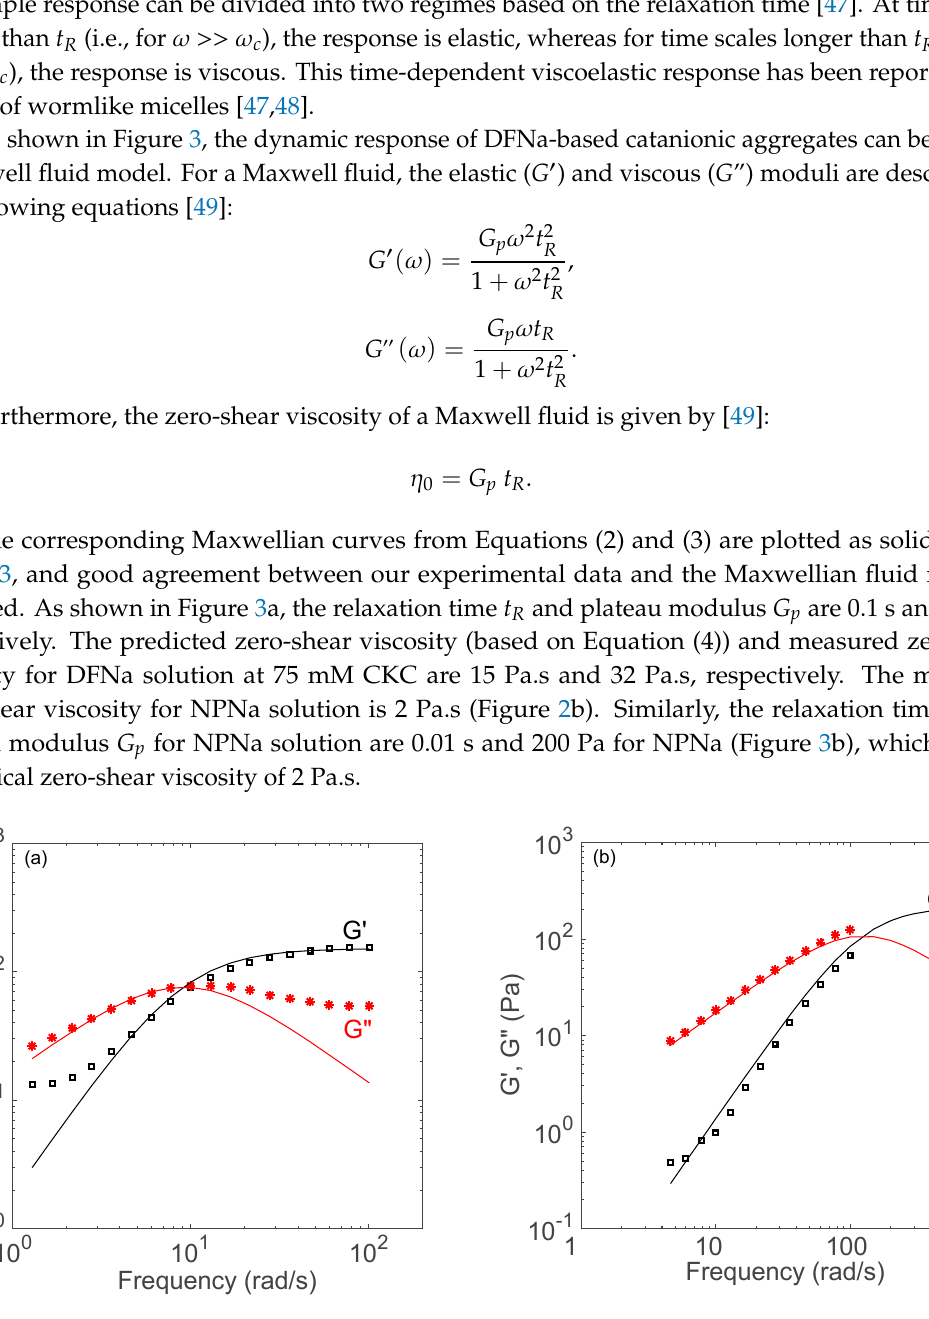
Figure 3. ( a ) Dynamic rheology of a 75 mM CKC sample with DFNa at 30 mM CKC. ( b ) Dynamic rheology of a 200 mM CKC sample with NPNa at 30 mM CKC. The elastic modulus G’ is shown as black unfilled squares and the viscous modulus G’’ is shown as red unfilled triangles. Measurements were performed at room temperature.